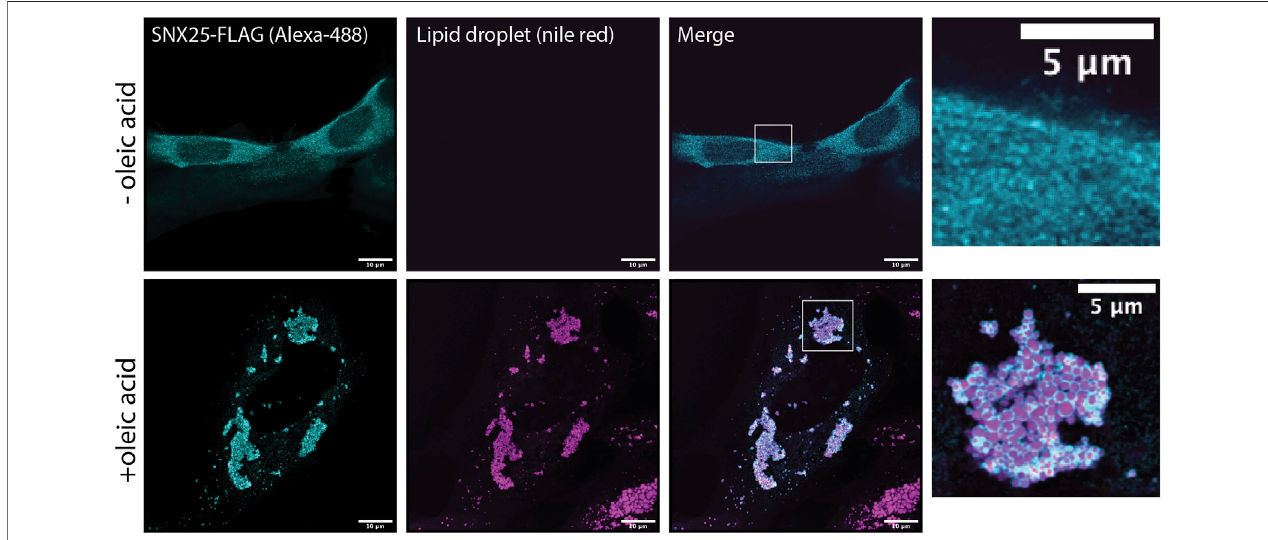
FIGURE 5 | Human SNX25 is localises to newly synthesised LDs following oleic acid addition. A431 cells were transfected with SNX25-FLAG and either left untreated or treated with 50 μ g/ml oleic acid to stimulate LD formation. After oleic acid addition SNX25-FLAG undergoes rapid redistribution to the periphery of newly generated LDs LD periphery. Scale bars represent 10 μ